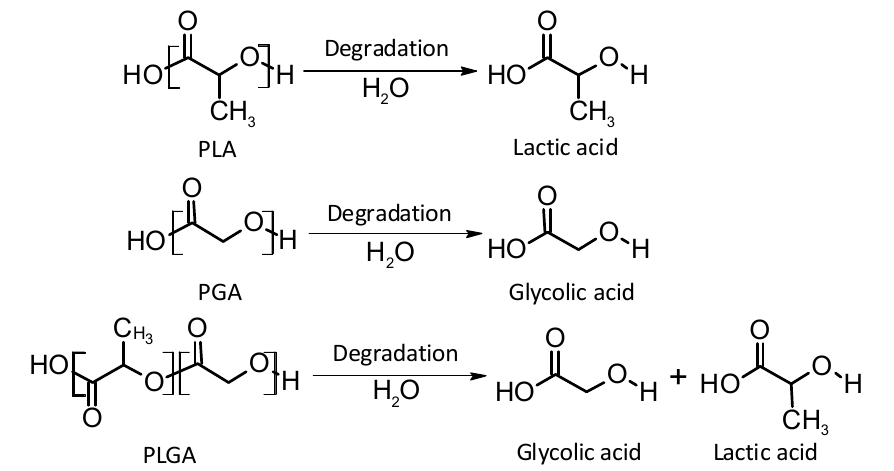
Figure 4. An illustration of the mechanisms of degradation of poly(lactic acid) (PLA); poly(glycolic acid) (PGA); and poly(lactic-co-glycolic acid) (PLGA). Poly(lactic